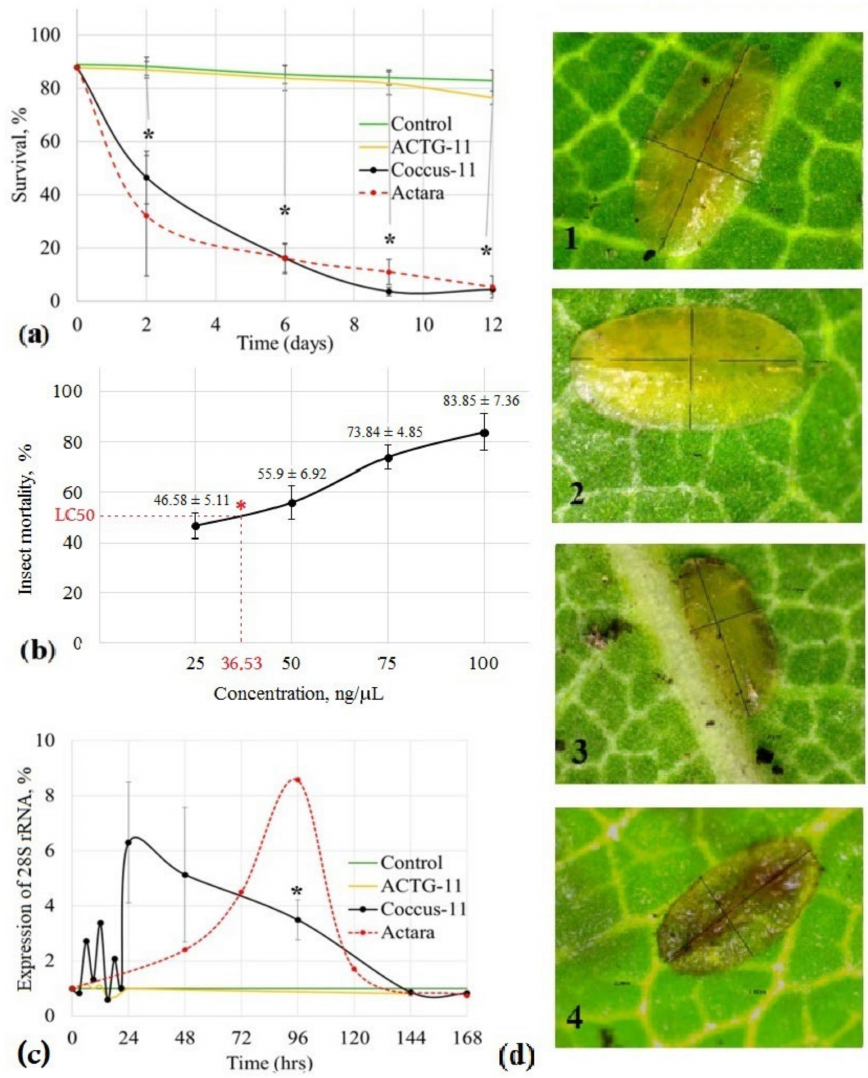
Figure 1. The effect of the ssDNA insecticide Coccus-11 on C. hesperidum larvae. The C. hesperidum larvae were treated topically with ssDNA insecticide (Coccus-11), with commercial neonicotinoid insecticide Actara ® (Actara), or with control ssDNA oligonucleotide ACTG-11 (ACTG-11) and water (Control). ( a ) Survival rate was calculated; ( b ) dose-effect curve for Coccus-11 (6th day of the experiment); LC50 is indicated by a red asterisk; ( c ) expression of 28S rRNA was analyzed by PCR, control was taken as 100%; ( d ) insect morphology was investigated with light microscopy: 1—control larva with intact integuments, 2—larva from ACTG-11 group with intact integuments, 3—larva from Coccus-11 group with tissue necrosis at the edges of larva body, 4—larva from Actara group with noticeable darkening of the body. Means and standard error of means are represented on panels ( a , b ); * is marked when p <